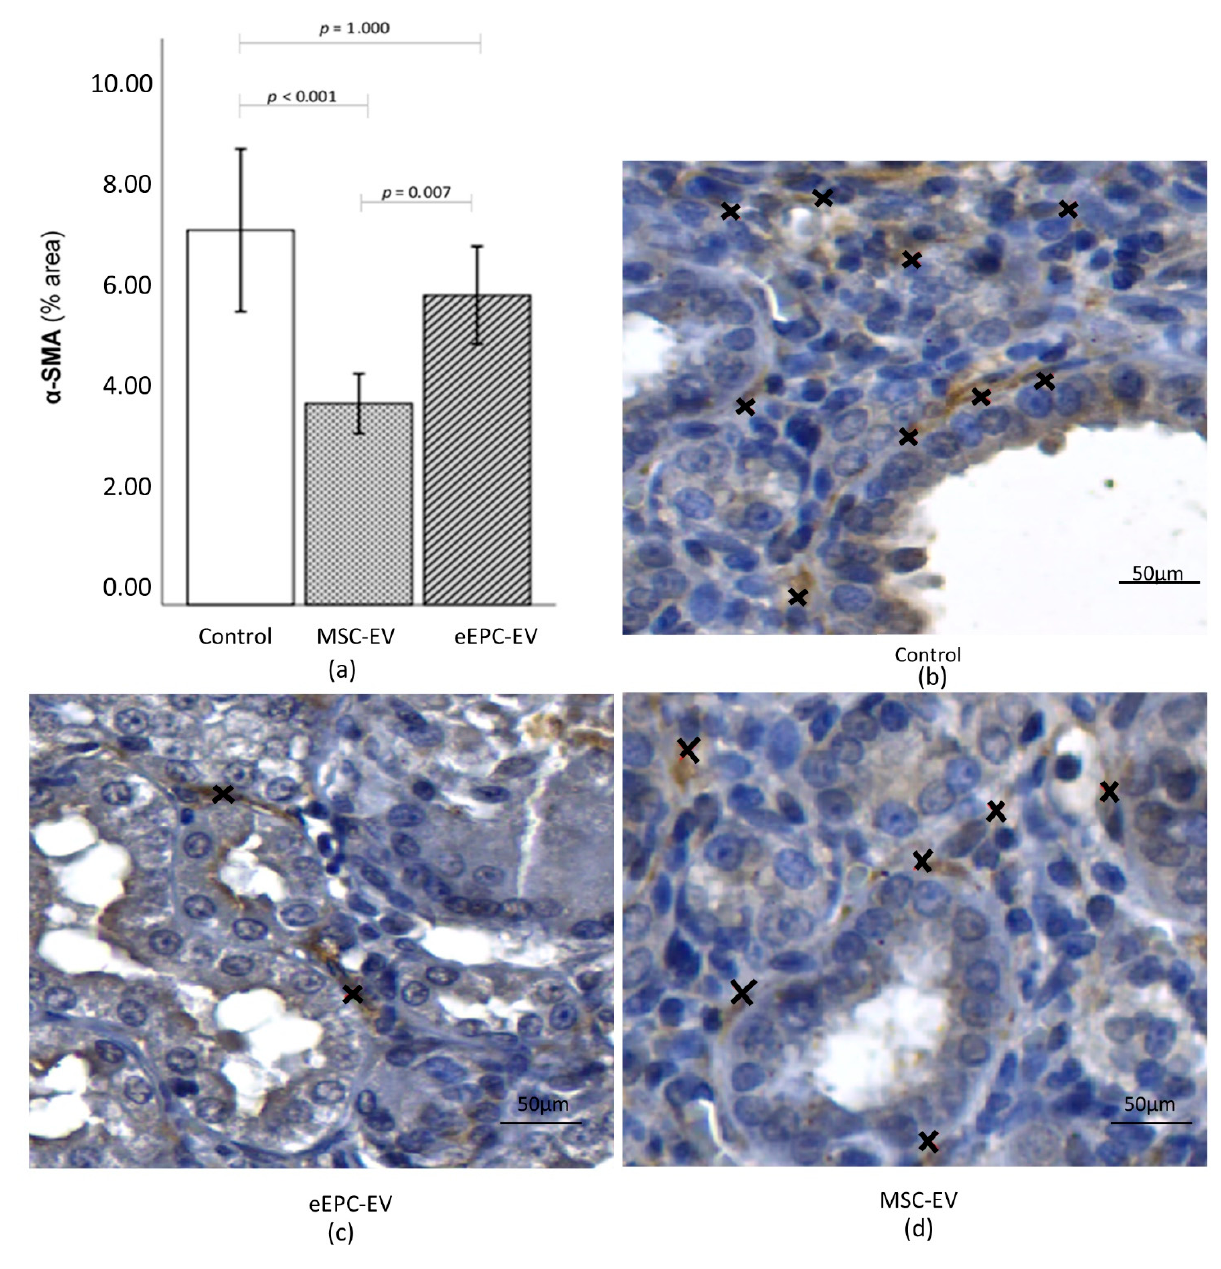
Figure 8. Immunohistochemical staining of α -SMA. ( a ) There was a significant difference in the ex- pression of α -SMA when comparing the C Group and the MSC-EV group ( p < 0.001) and MSC-EV and the eEPC-EV group ( p = 0.007). The data in figure are the mean ± sd. p < 0.05 is considered significant. ( b – d ) α -SMA expression (x) in ( b ) (Group C) was higher than that observed in ( c , d ) (groups eEPC-EV and MSC-EV,